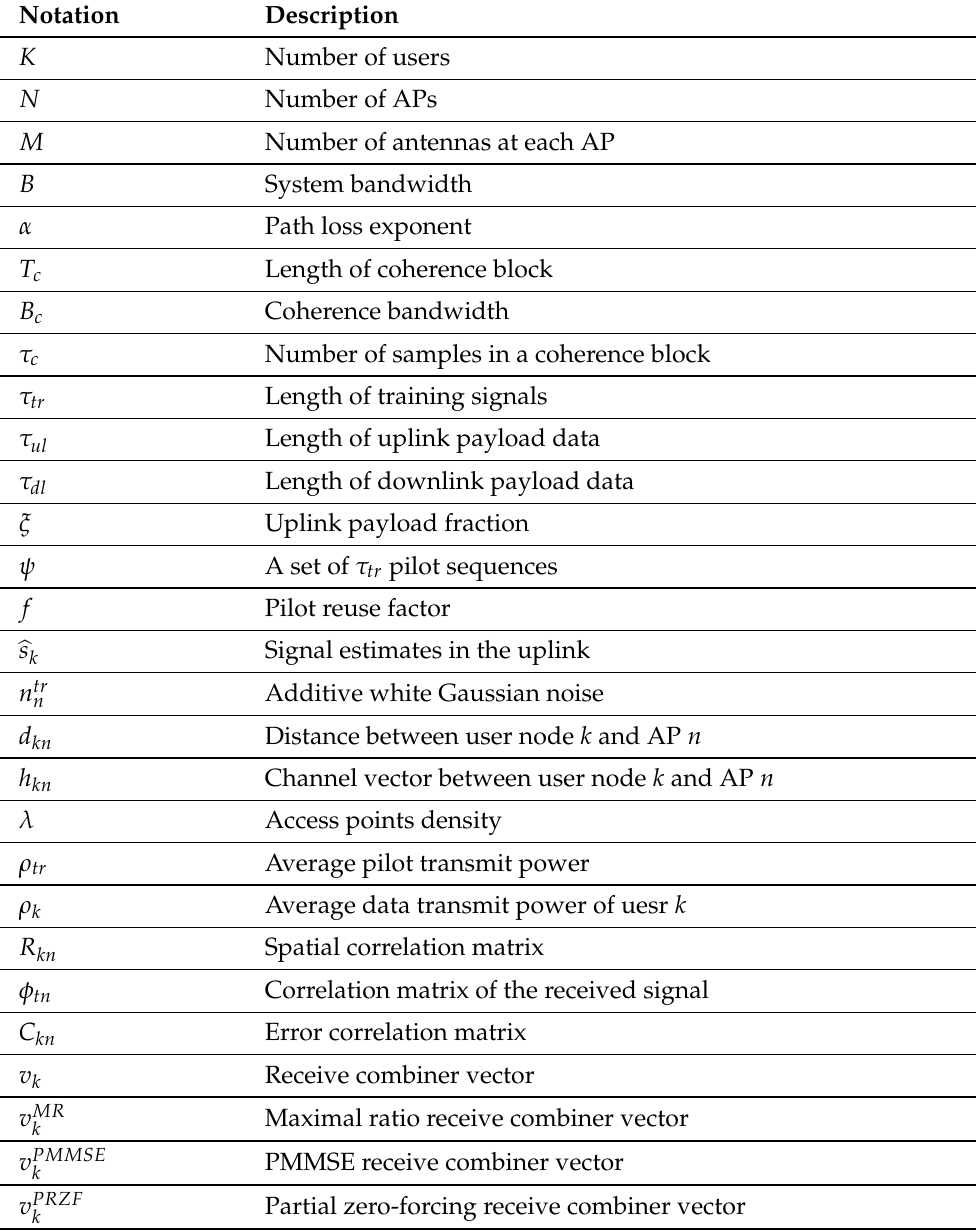
Table 1. Summary of